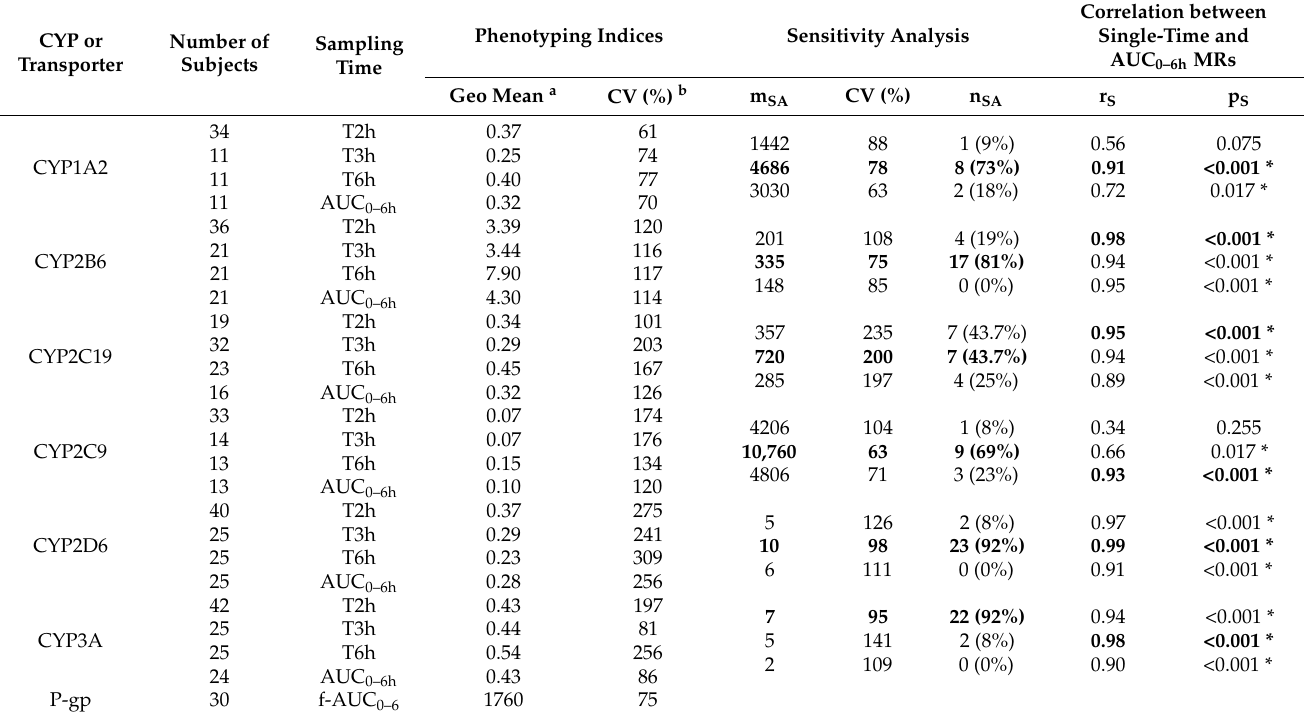
Table 3. Phenotyping indices for CYP and P-gp probe drugs and sensitivity analysis and correlation between single-time and AUC 0–6h MRs.